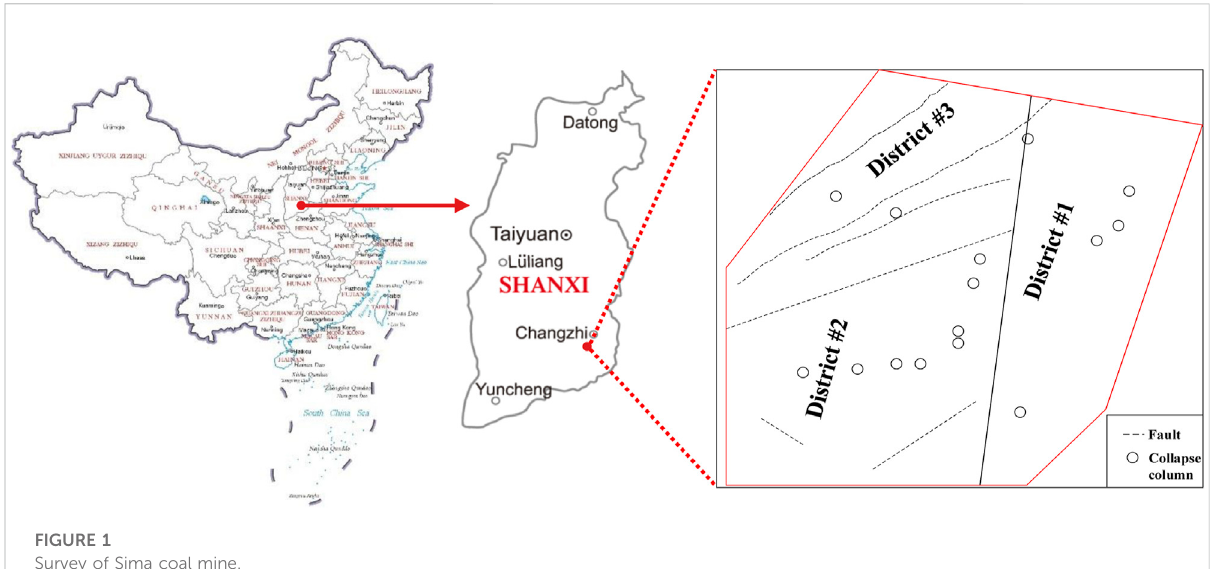
FIGURE 1 Survey of Sima coal